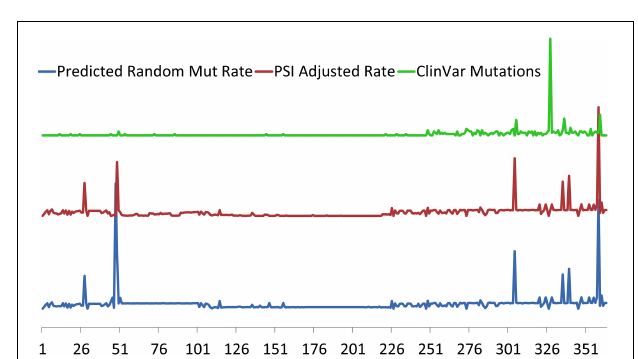
FIGURE 2 | Relative predicted rates of purely random mutations in TTN based on exon size (bottom, blue) and adjusted for cardiac exon expression (middle red) using Proportion Spliced In (PSI) approach of Roberts et al. (2015). Regions of where PSI is generally < 50% include exons 51–69, 78–89, and 124–220. Exon location of 327 clinically relevant TTN truncation variants from ClinVar (top, green) demonstrates clustering toward the carboxy terminus of TTN in the region of the A-band where most of the constitutively expressed exons are located. Exons indicated on horizontal